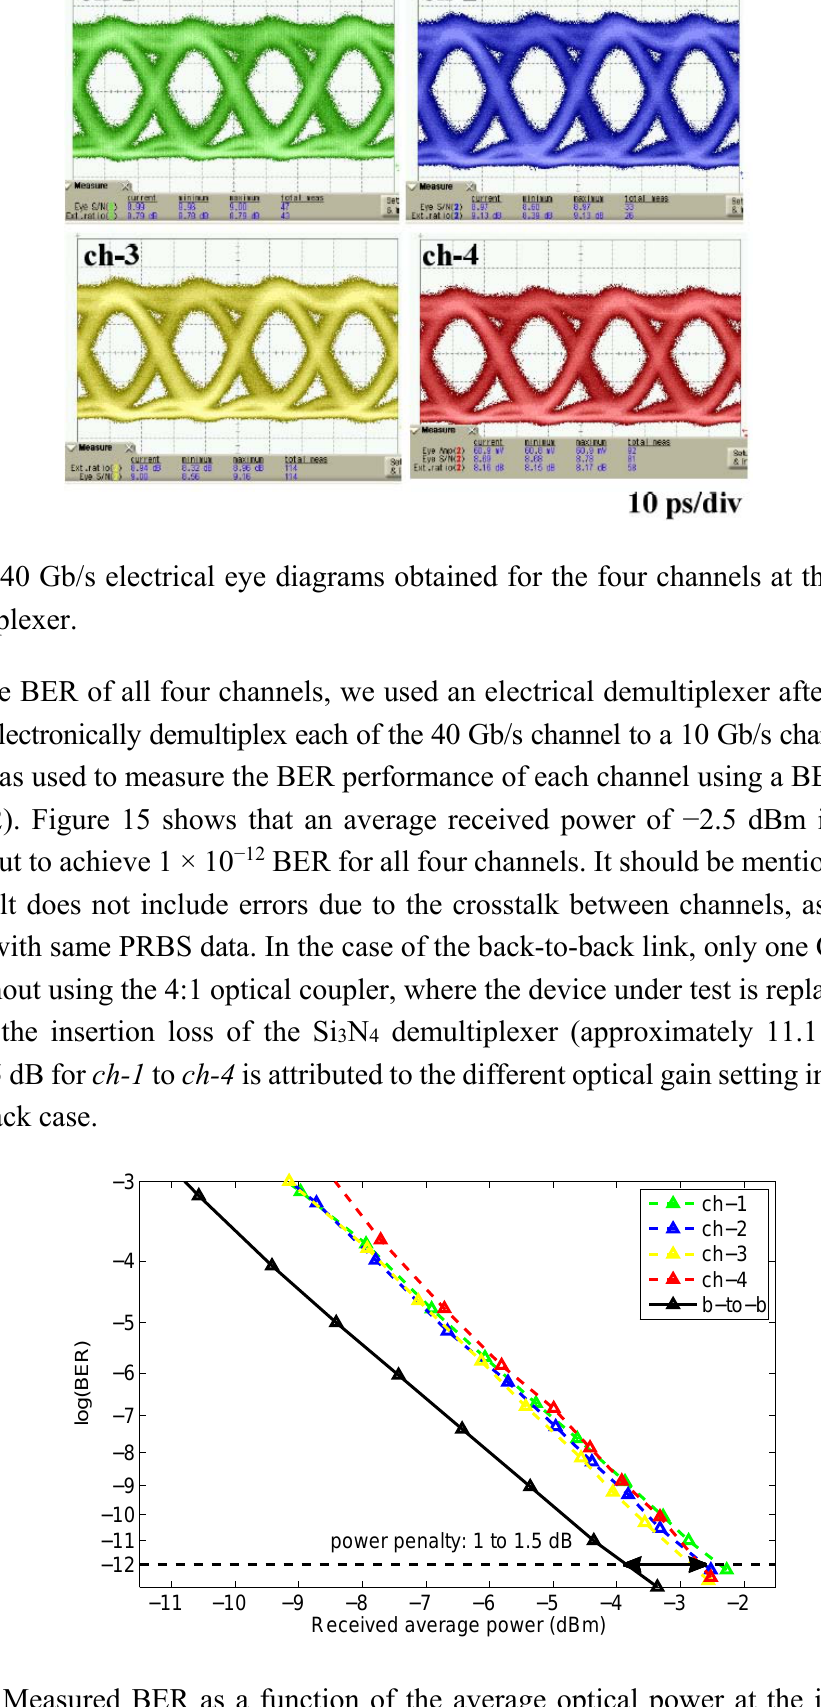
Figure 15. Measured BER as a function of the average optical power at the input of the photodetector for the back-to-back and four output channels of the